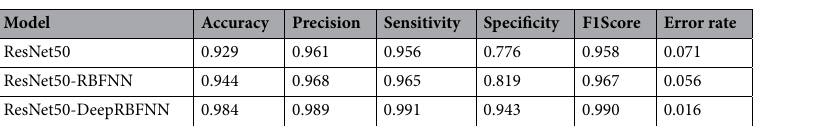
Table 4. Classification performance of the proposed